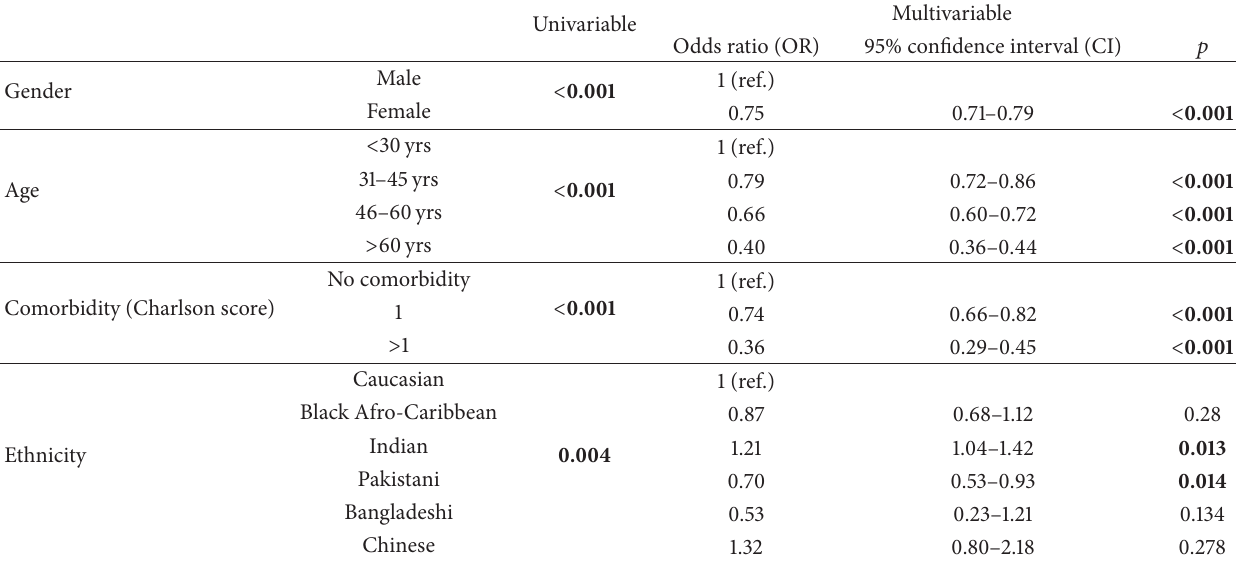
Table 5: Logistic regression model of predictors of colectomy for ulcerative